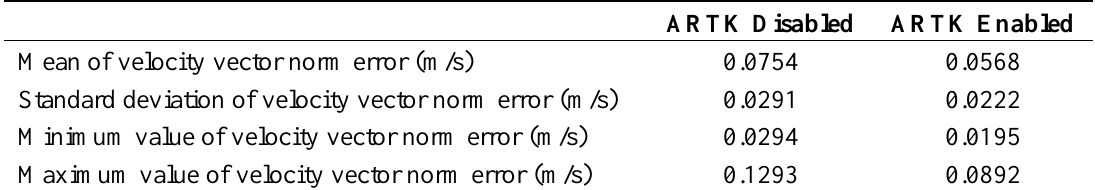
Table 2. Mean value, standard deviation and maximum value of data, presented in Table